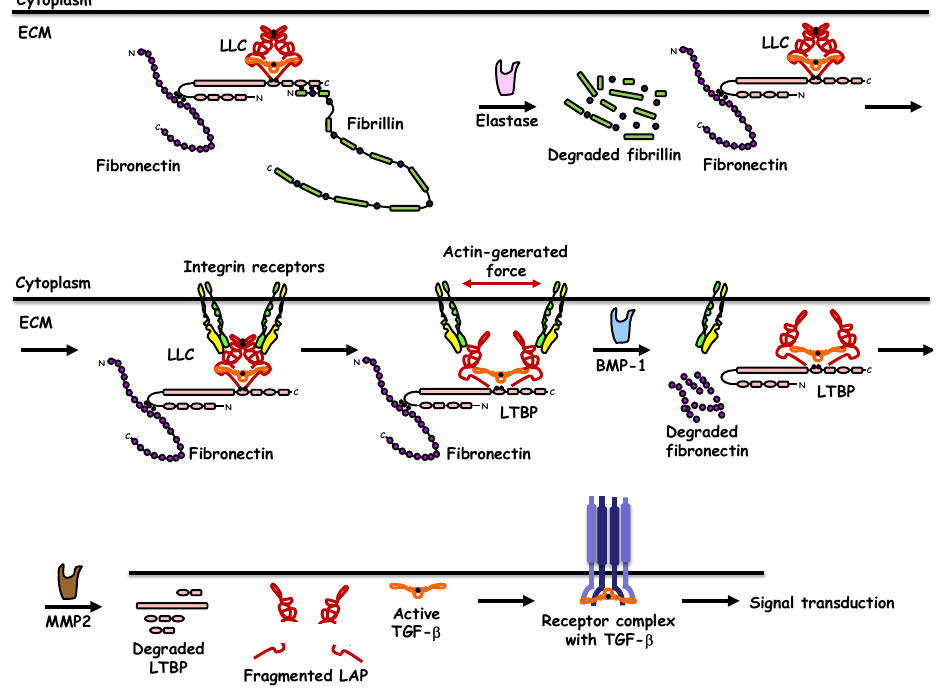
Figure 2. Activation of latent TGF-β. A sequence of biochemical events is shown from the top left to the bottom right, guided by black arrows. The large latent complex of TGF-β (LLC) deposited to the ECM via crosslinking to fibronectin and fibrillin is shown. Elastase proteolytically cleaves fibrillin. Integrin receptors on the plasma membrane associate with the RGD peptides (not shown) of the TGF- β prodomain. Integrin heterodimers of α- and β- integrin chains are shown in different color. Integrins, via their association to the actin cytoskeleton (not shown) exert force and change the conformation of the LLC prodomain, initiating the mature TGF-β release process. BMP-1 proteolytically cleaves fibronectin and MMP2 cleaves LTBP and the prodomain of TGF-β, generating fragmented prodomain, i.e., latency associated peptide (LAP), and releasing mature TGF-β. Active TGF-β associates with the signaling type II and type I receptors and initiates signal transduction. The role of coreceptors in ligand presentation is not shown.